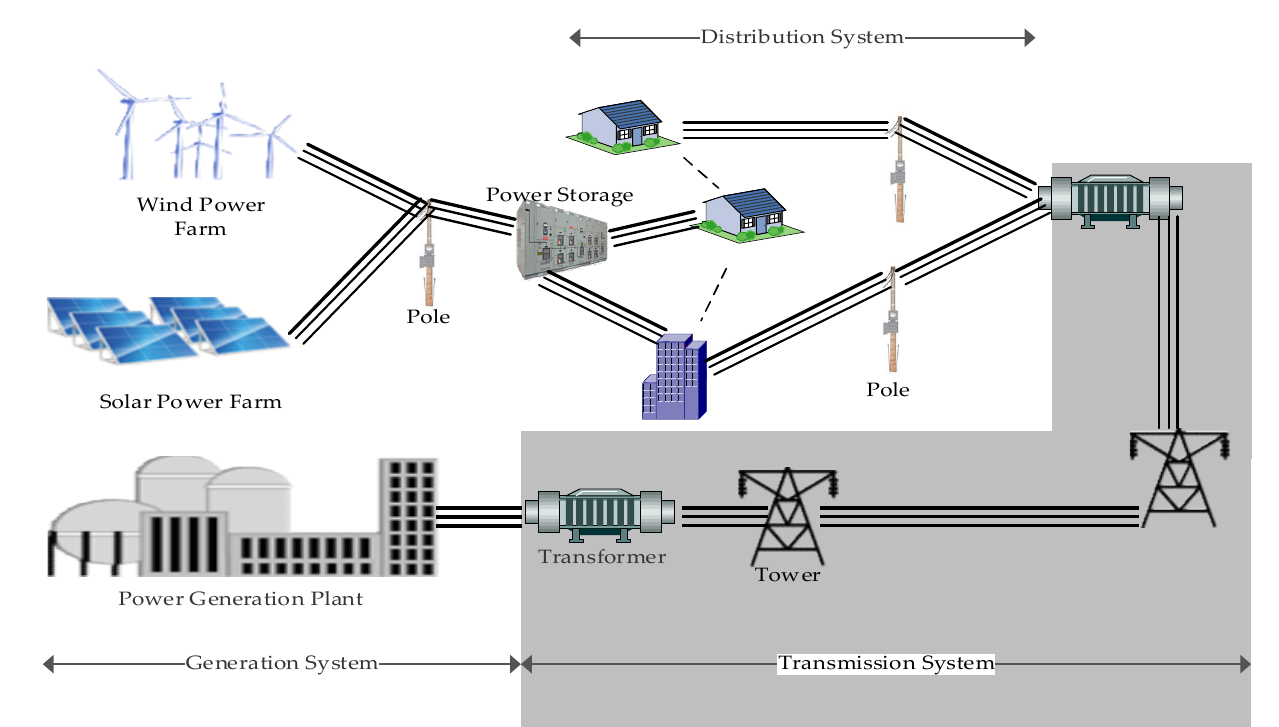
Figure 1. A schematic of a Power Grid System, where the gray-shaded part represents the transmission system.